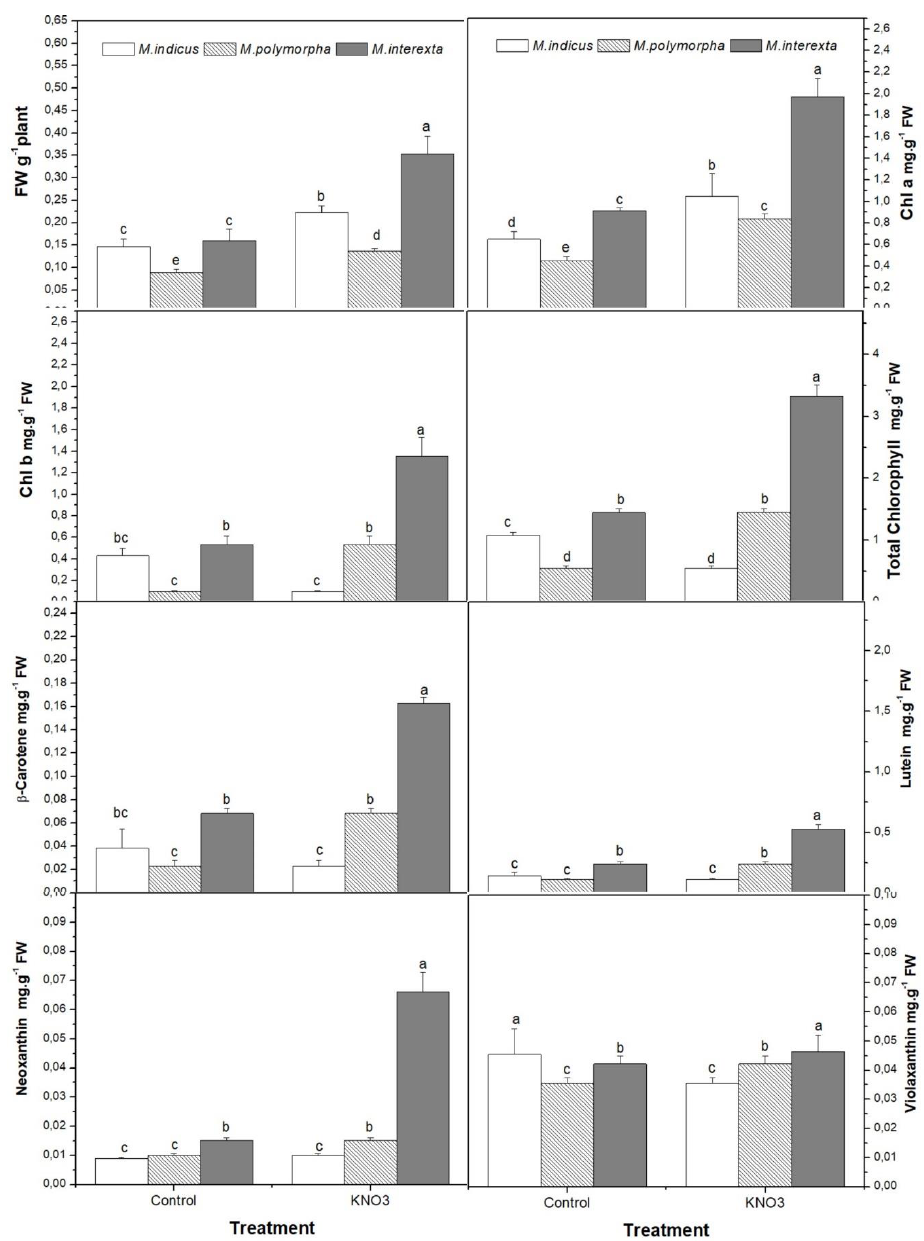
Figure 1. Effect of KNO 3 priming on total fresh weight and leaf pigments contents of three species of Medicago sprouts. Values are represented by mean ± standard deviation of at least three independent replicates. Within the same species, different letters on the bars indicate significant differences at p < 0.05.